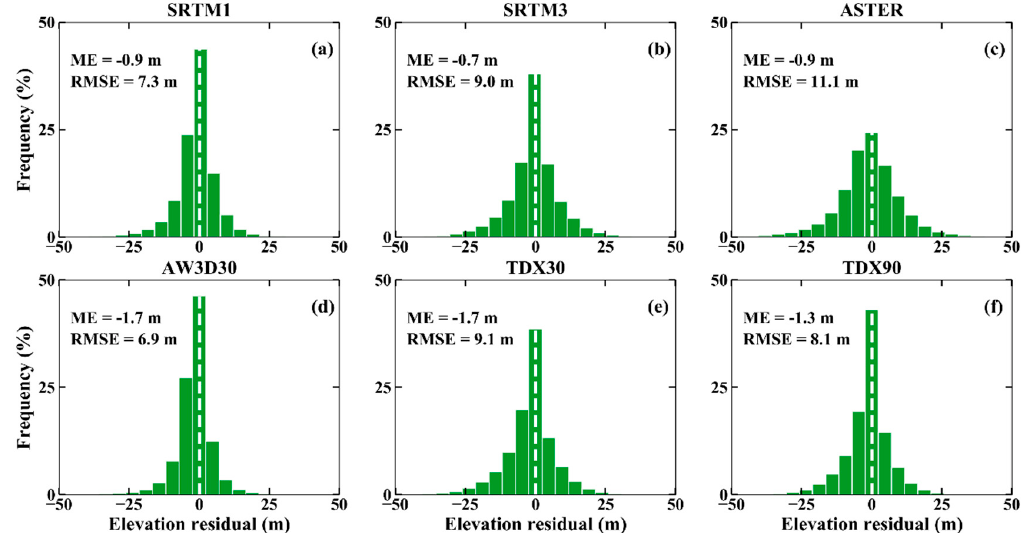
Figure 8. Histogram plot of elevation errors for ( a ) SRTM1; ( b ) SRTM3; ( c ) ASTER; ( d ) AW3D30; ( e ) TDX30 and ( f ) TDX90.In addition, ASTER GDEM2 (~30 m spatial resolution) has the lowest accuracy